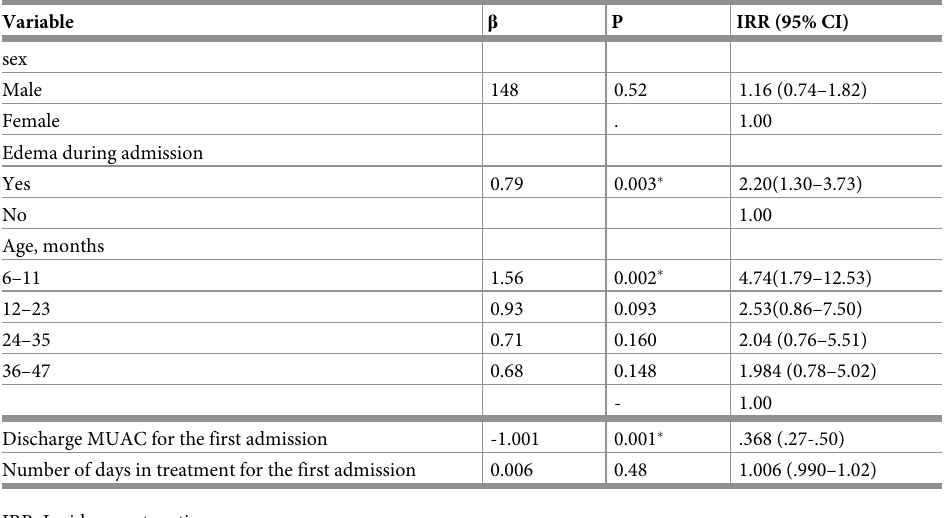
Table 4. Negative binomial regression model for factors associated with incidence rate ratio (IRR) of relapse of SAM case in Hadiya Zone, SNNPR, Ethiopia. 2014/2015-2019/2020 (n =